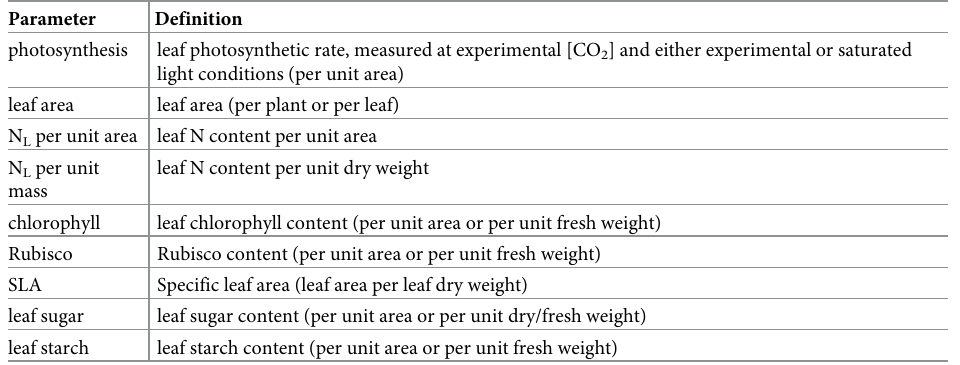
Table 1. List of response variables examined in the